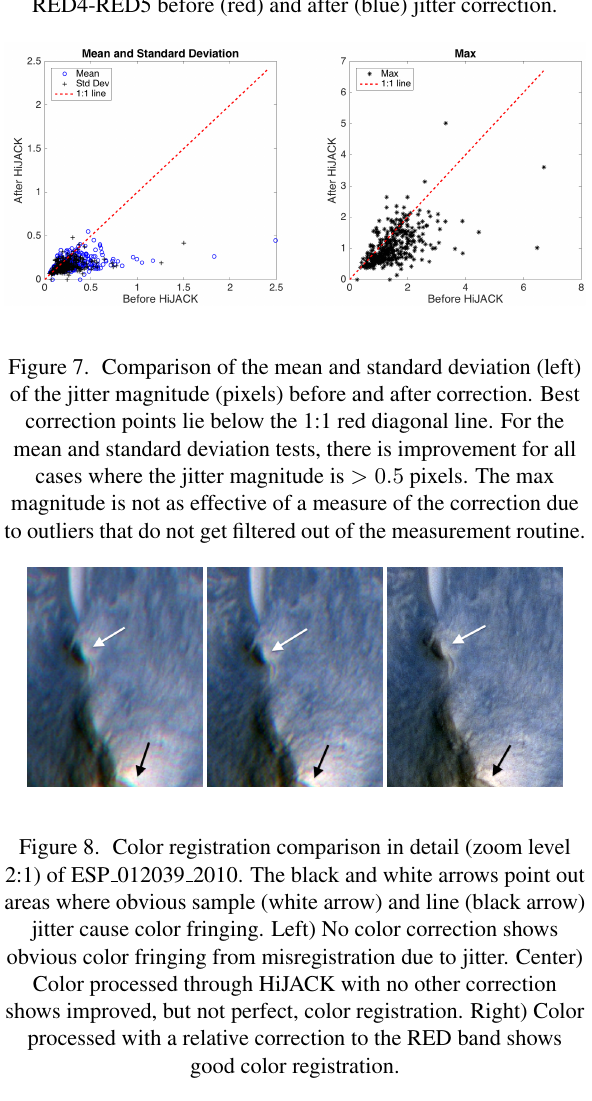
Figure 6. Plot of hijitreg results from ESP 019988 1750 RED4-RED5 before (red) and after (blue) jitter correction.